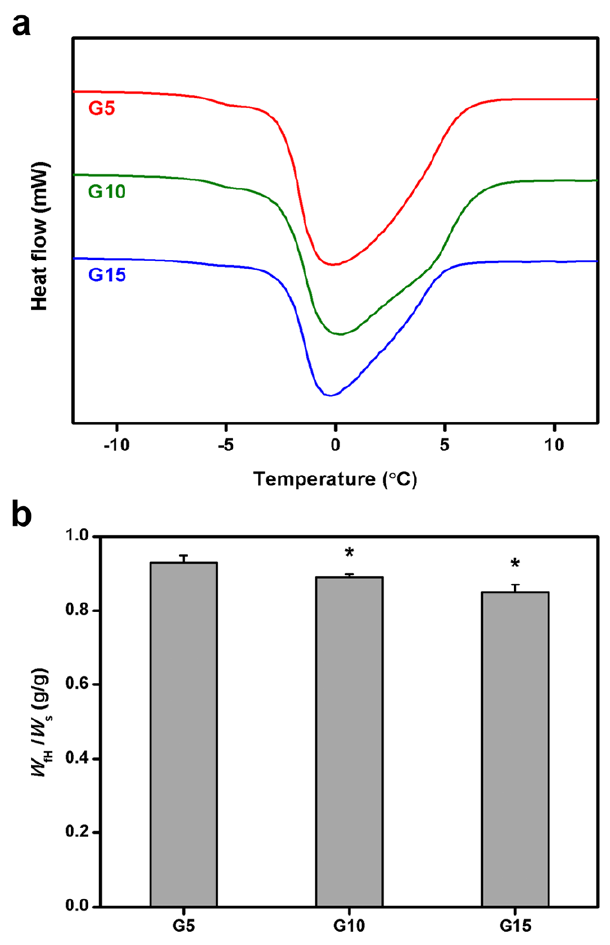
Figure 5. Determination of freezable water content. (a) Typical DSC thermograms of swollen gelatin hydrogel discs. (b) Freezable water content ( W fH / W s ) of various gelatin samples. An asterisk indicates statistically significant differences (* P , 0.05; n =6) as compared with the G5 groups.